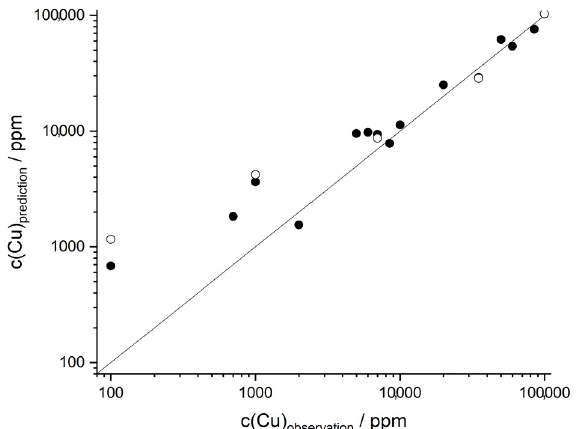
Figure 3. PLSR of CuFeS 2 data in basalt at Echelle spectrometer. The logarithms of the copper concentrations and 2 components were used for the regression model. Black dots represent calibration model (R 2 CV = 0.97, RMSECV = 5016 ppm), circles represent validation (R 2 V = 0.95, RMSEV = 5012